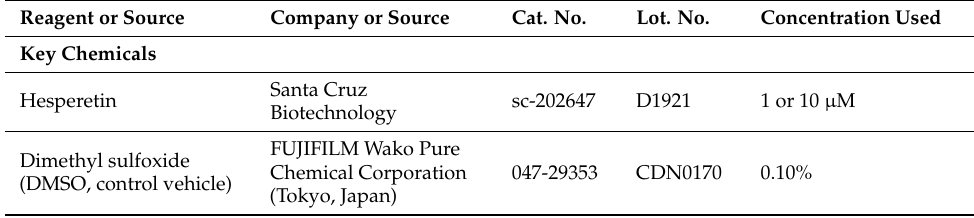
Table 2. List of